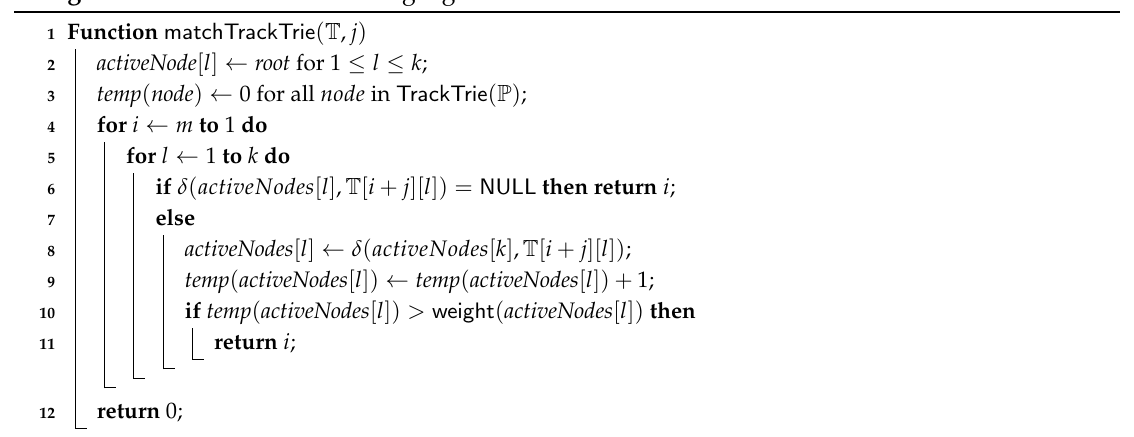
Algorithm 13: Track trie matching